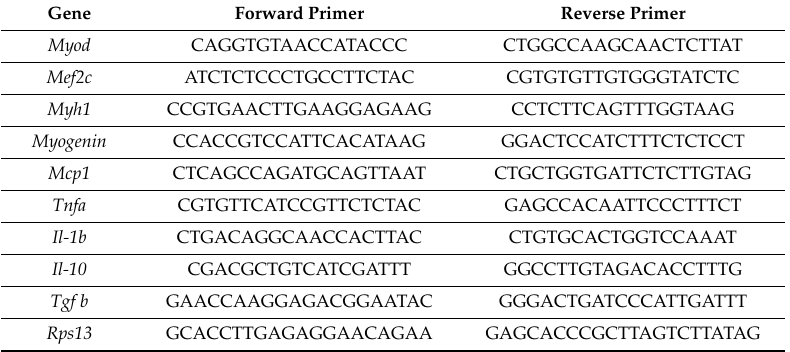
Table 1. List of primers for qPCR analysis (primers from IDT